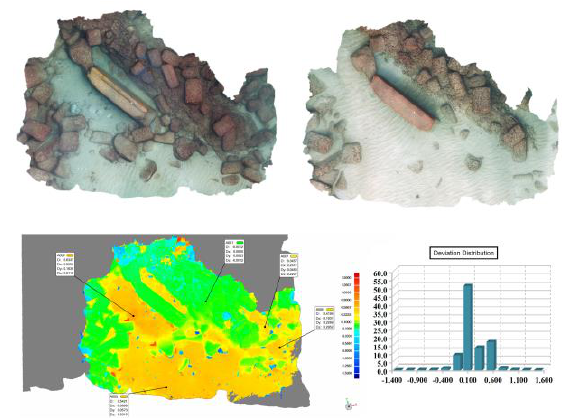
Figure 16. Above, a part of camera positions of small area of the site; below, Camera positions of 7200 m 2 (50152 images) from 2014 until 2016 (Mohamed Abdelaziz)